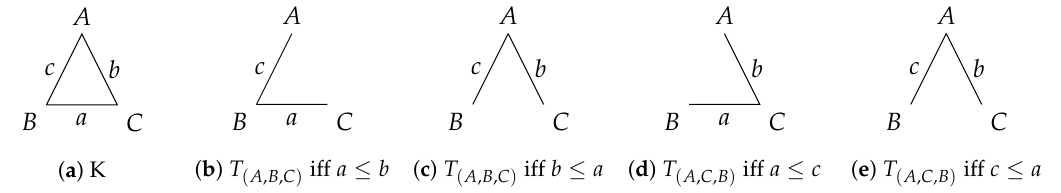
Figure 2. (a) Base triangle K and four cases ( b – e ) after joining B and C to A